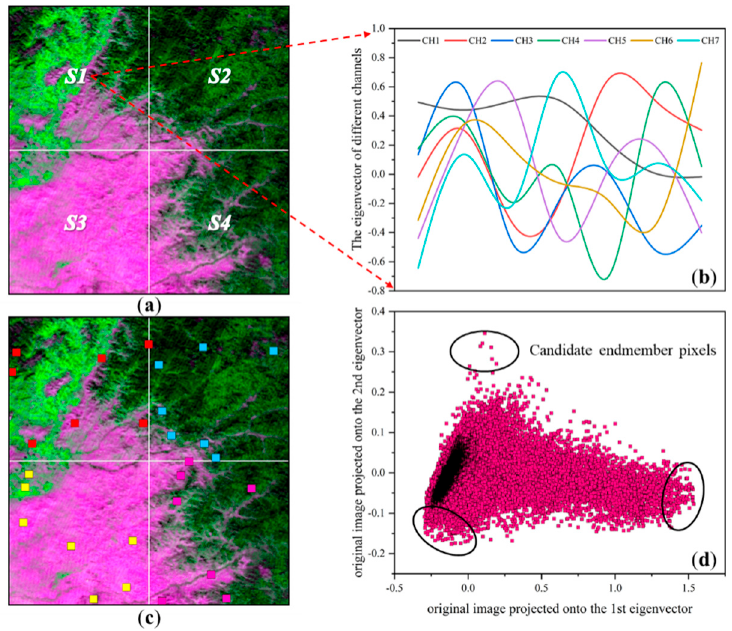
Figure 3. Extraction candidate endmembers from diverse images. ( a ) the entire image is divided into subregions of the same size. ( b ) calculate the eigenvectors for each subregion. ( c ) the subregions of the original image are projected onto the extracted eigenvectors, and the candidate endmember pixels are located at the extremes of the projection space. ( d ) the candidate pixels of the subregion S1 .